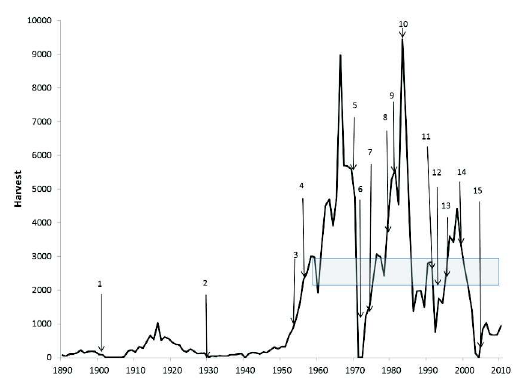
Figure 1. Harvest data for the Norwegian Hardangervidda wild reindeer herd for the period 1890 - 2010 based on of- ficial hunting statistics. The vertical arrows indicate when various management measures were implemented (see Table 1 for a detailed description). Shaded rectangular area indicates the harvest range of 2300 - 3000 animals predicted to be necessary for maintaining a carrying ca- pacity winter herd of 9000 - 12 000 (Svein Erik Lund pers.